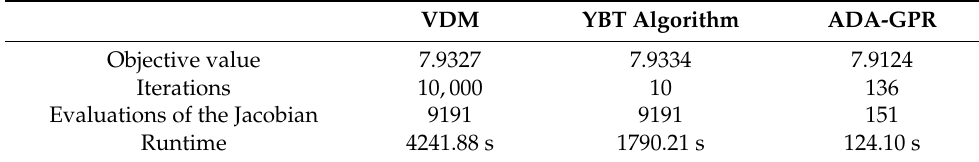
Table 4. Objective values, runtime and number of iterations of all three algorithms for the flash with a methanol-water input feed.